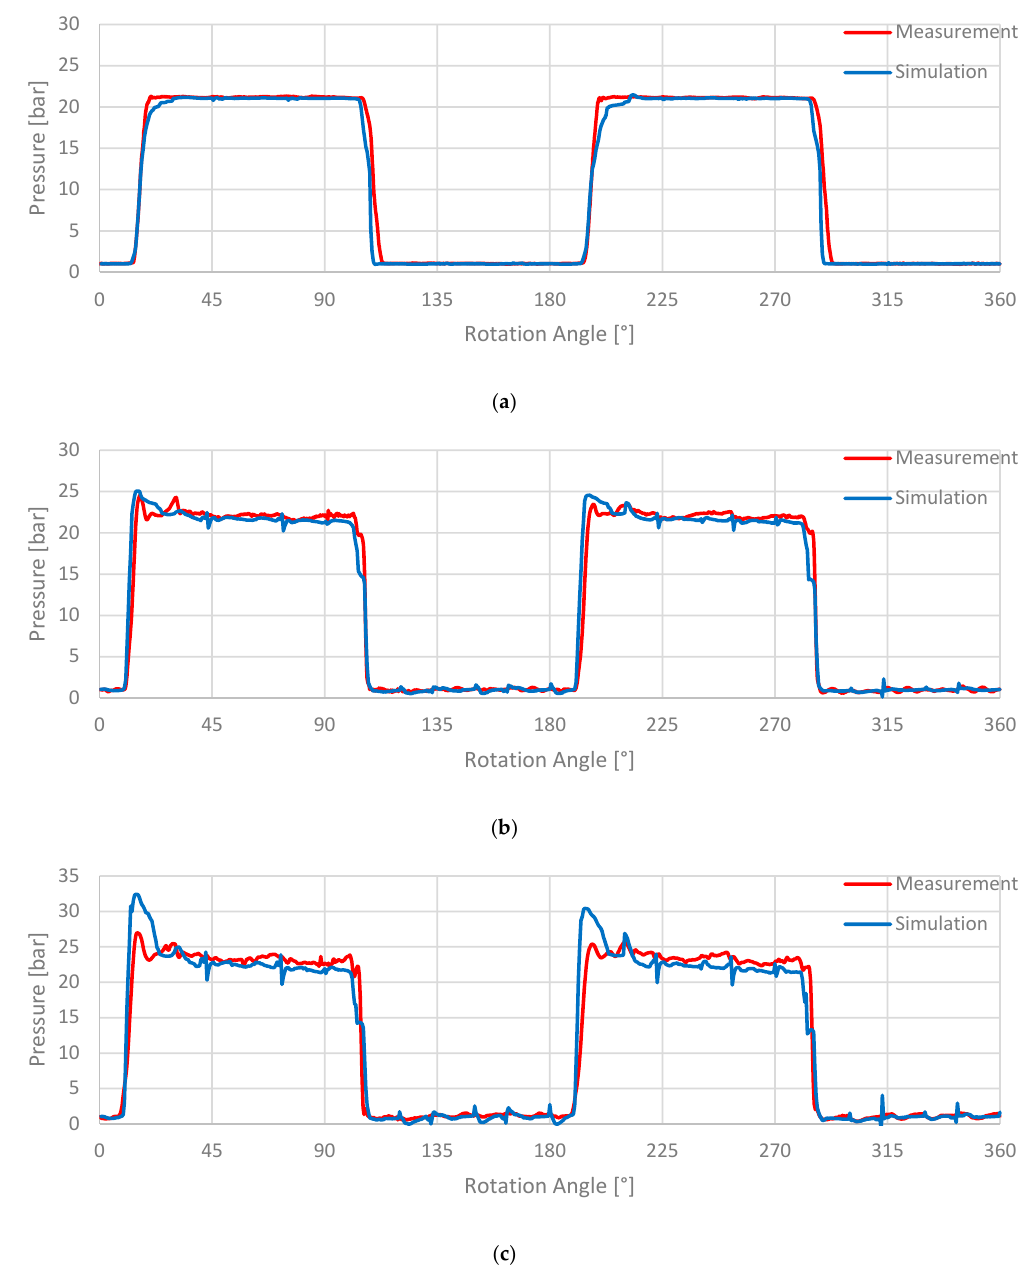
Figure 13. Comparison of measurement and simulation at a constant delivery pressure of 20 bar at di ff erent rotational speeds ( a ) 500 rpm; ( b ) 2000 rpm; ( c ) 3000